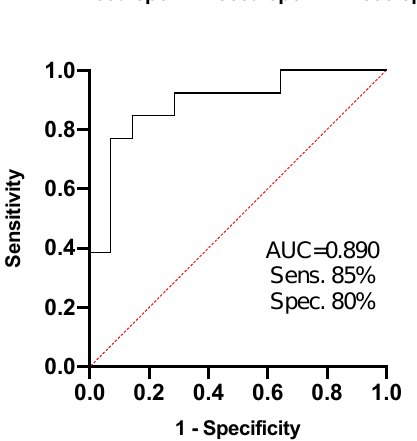
Figure 2. Receiver operating characteristic analysis of the use of miR-99a-5p, miR-365a-3p, and miR-200c-3p combination (Pscore) in the discriminating between the PDAC patients with good and poor prognosis. AUC: area under the curve.